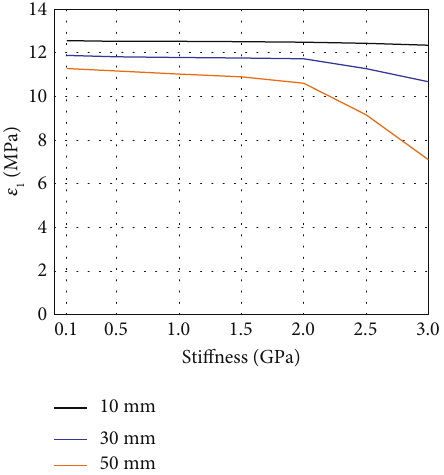
Figure 9: Peak strain of limestone grouting reinforcement bodies under di ff erent crack lengths and di ff erent sti ff ness values of grouting stone